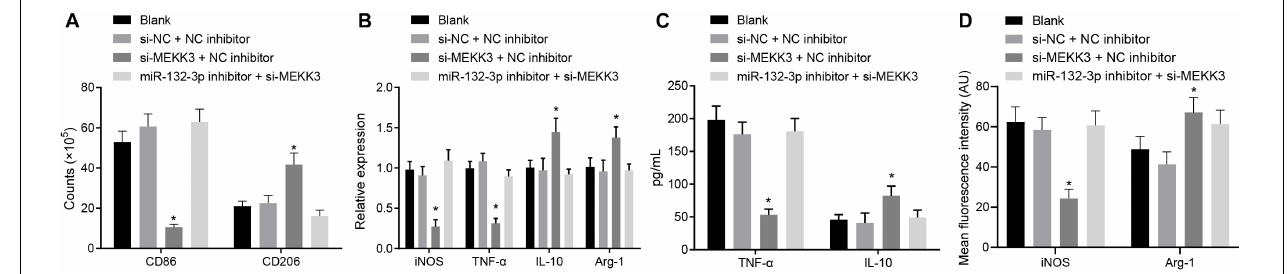
FIGURE 4 | miR-132-3p inhibits the M1 polarization of macrophages from SCIR injury rats by down-regulating MEKK3. The macrophages were transfected with both si-NC and NC inhibitor, both si-MEKK3 and NC inhibitor, or both miR-132-3p inhibitor and si-MEKK3. (A) Expression of CD86 (a specific marker of M1 phenotype) and CD206 (a specific marker of M2 phenotype) in macrophages detected by flow cytometry. (B) Expression of inflammatory factors iNOS, TNF- α , IL-10, and Arg-1 in macrophages detected by RT-qPCR. (C) The level of TNF- α and IL-10 in macrophages measured by ELISA. (D) Expression of iNOS and Arg-1 in macrophages detected by immunofluorescence staining. * p < 0.05 vs. macrophages transfected with both si-NC and NC inhibitor. Measurement data were expressed as mean ± standard deviation. Comparisons of data among multiple groups were conducted by one-way ANOVA. The experiment was repeated three times independently.